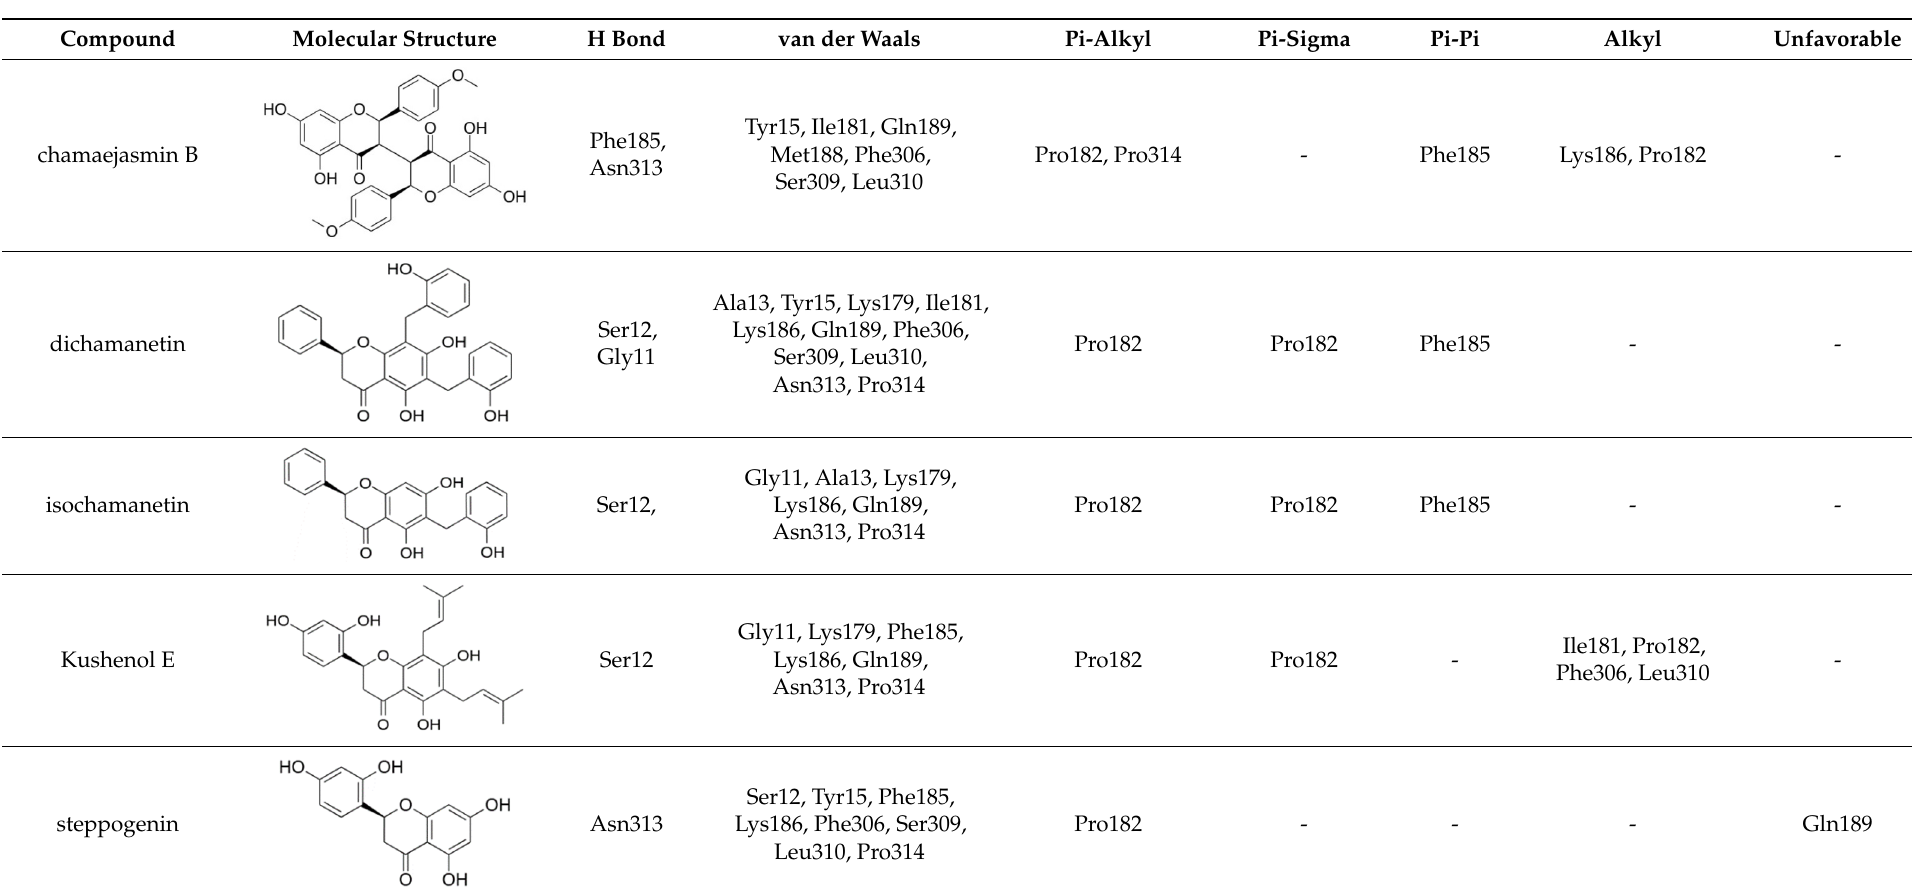
Table 2. The interacting amino acid residues of IDO1 with chamaejasmin B, dichamanetin, isochamanetin, Kushenol E, and steppogenin.